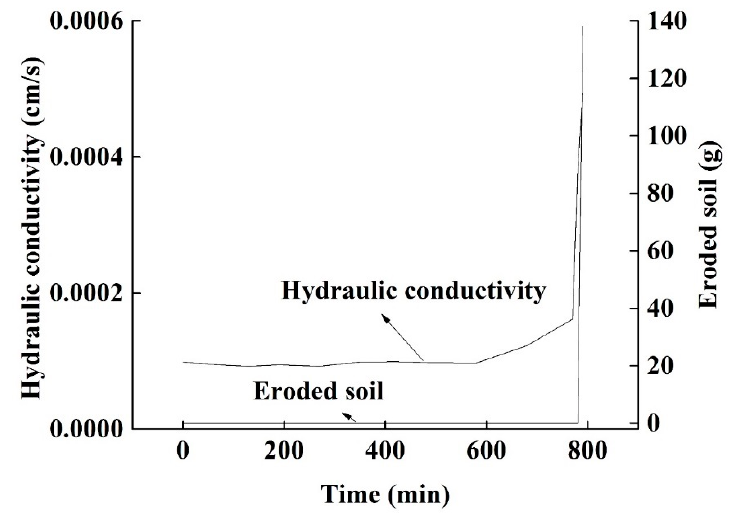
Figure 5. Hydraulic conductivity and eroded soil-t curve of II-1.